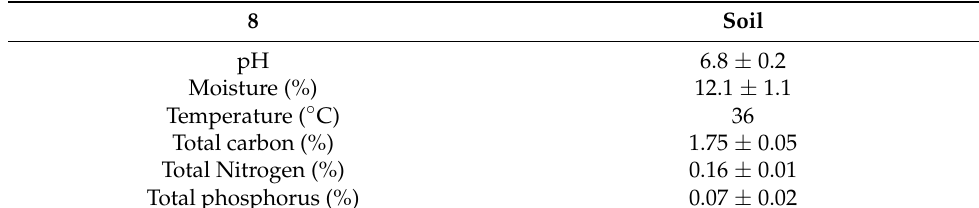
Table 1. Physical-chemical analyses of soil ( ± standard deviation, n = 3).